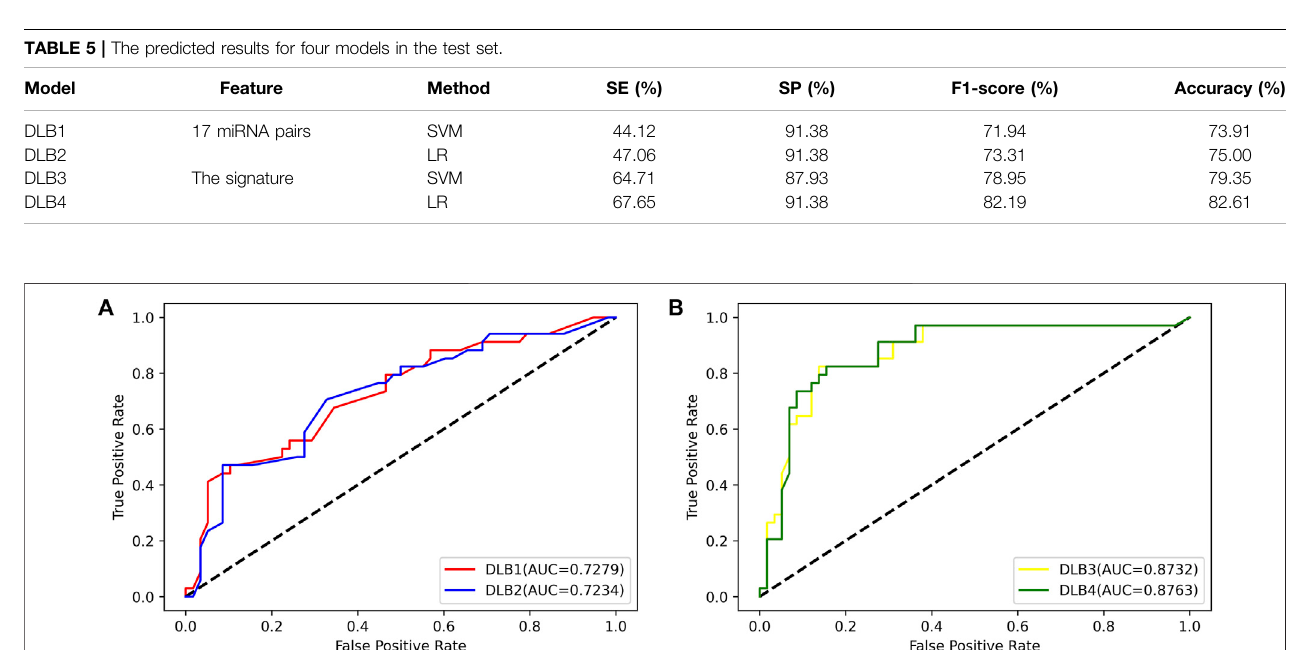
FIGURE 4 | ROC curves for four models in the test set. (A) ROC curves of 17-miRNA-pairs-based models (DLB1 and DLB2). (B) ROC curves of the-signature- based models (DLB3 and DLB4).